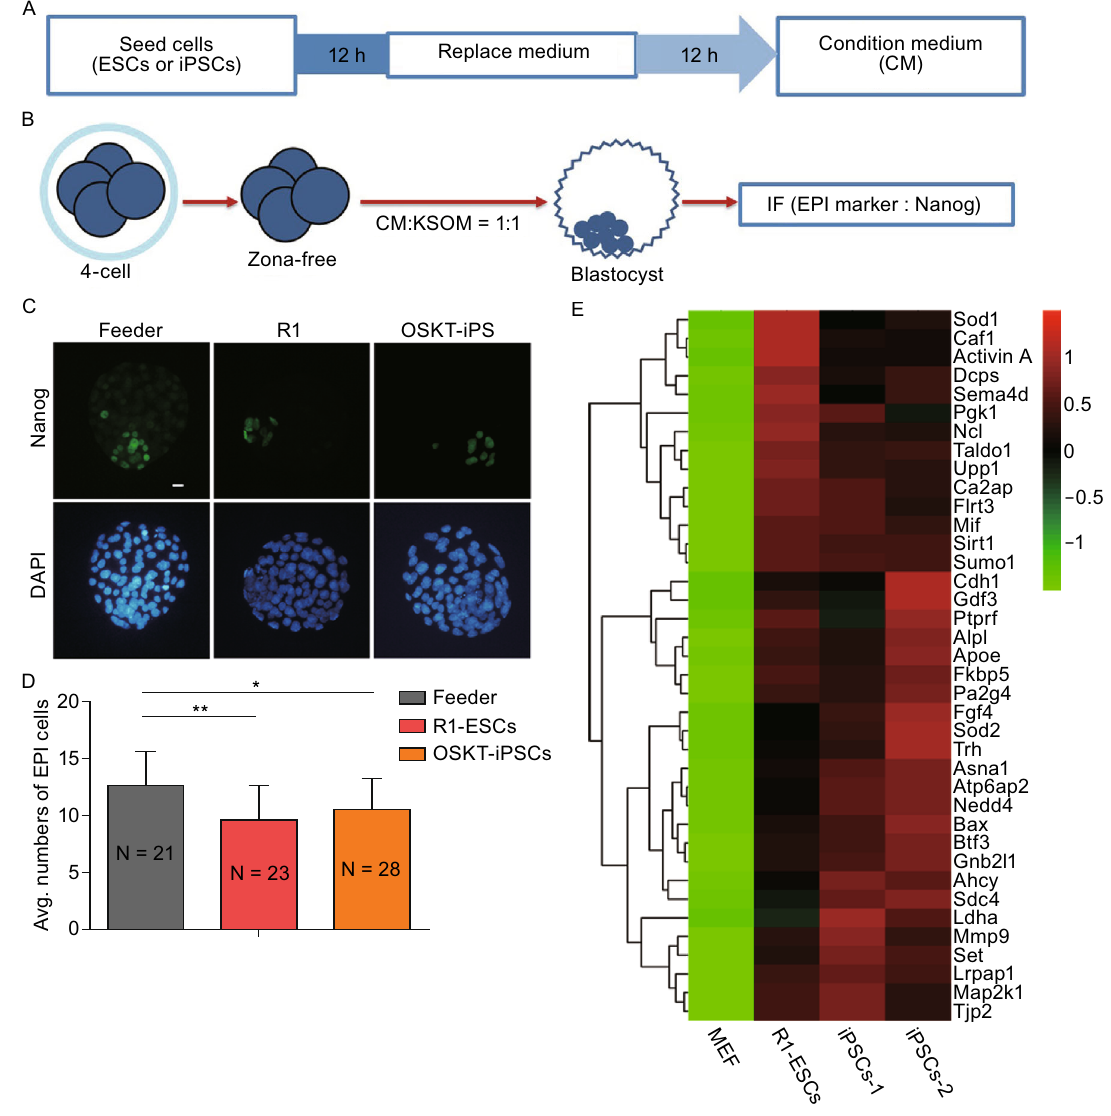
Figure 2. Secretions from ESCs and iPSCs affect EPI development. (A) Schematic of the method used to collect the condition medium. (B) Experimental design. Zona-free embryos at 4-cell stage were treated in the mixed medium containing KSOM and CM and then immunostained at E4.5 to test the effect of the condition medium on early embryo development fate. CM, condition medium. (C) Nanog immunostaining in E4.5 embryos treated with condition medium from feeder, R1 ESCs and iPSCs. Nuclei were stained with DAPI (Blue). Scale bars, 20 μ m. (D) Average numbers of EPI cells (Nanog-positive cells) in condition medium-treated embryos at E4.5. Error bars indicate SD. * P < 0.05; ** P < 0.01 by ANOVA. N is the number of embryos examined. (E) Heatmap of ESC and iPSC- secreted proteins at high expression levels. The heatmap was plotted with relative protein